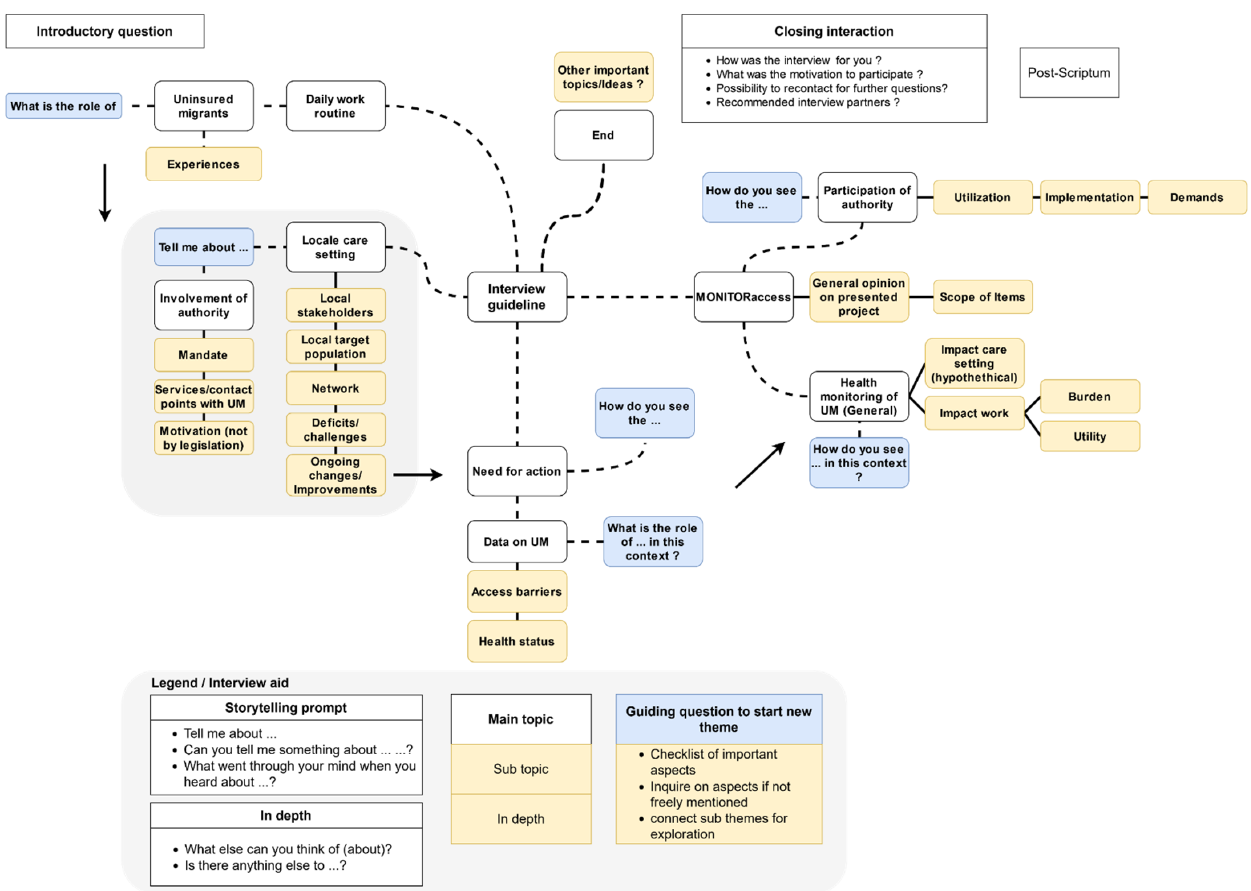
Figure 1. English courtesy translation of the interview guide. For the original version in German, see Supplementary File S1. The arrows indicate the typical order of topics discussed in the inter- views. Table 1. Exemplary application of the interview guide from the interview with expert P6. See Figure 1 and Supplementary File S1 (German original version) for the full interview guide.